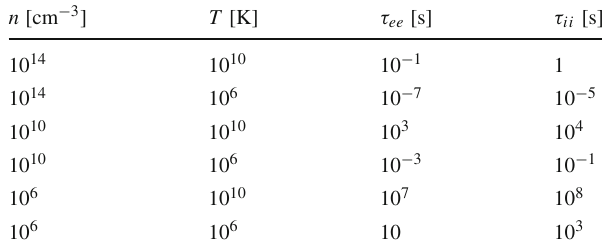
Table 6 Collision timescale of electron–electron τ ee and ion-ion τ ee collisions in a plasma of given particle density and temperature. The plasma is considered quasi-neutral with equal temperatures of the com- ponents. The values are rounded to the orders of